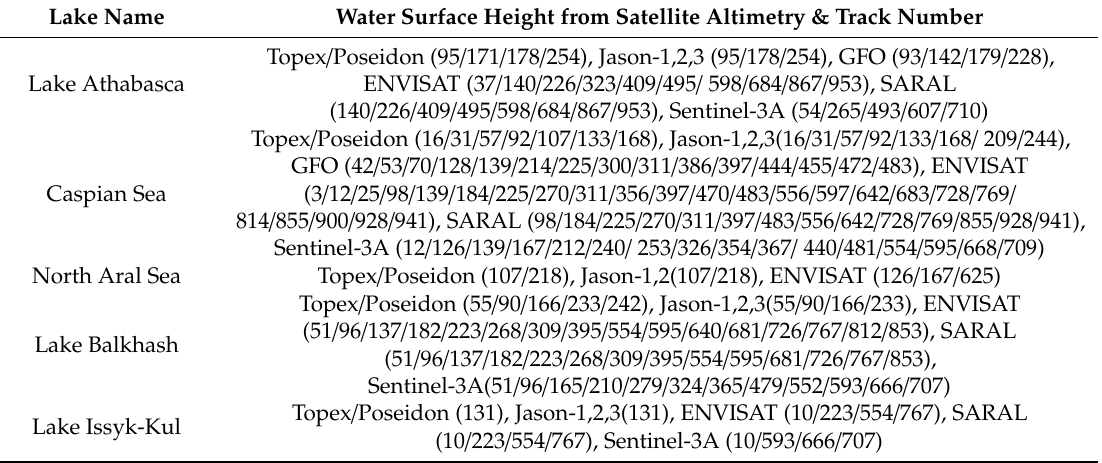
Table 3. Water surface height from satellite altimetry and track number of satellite